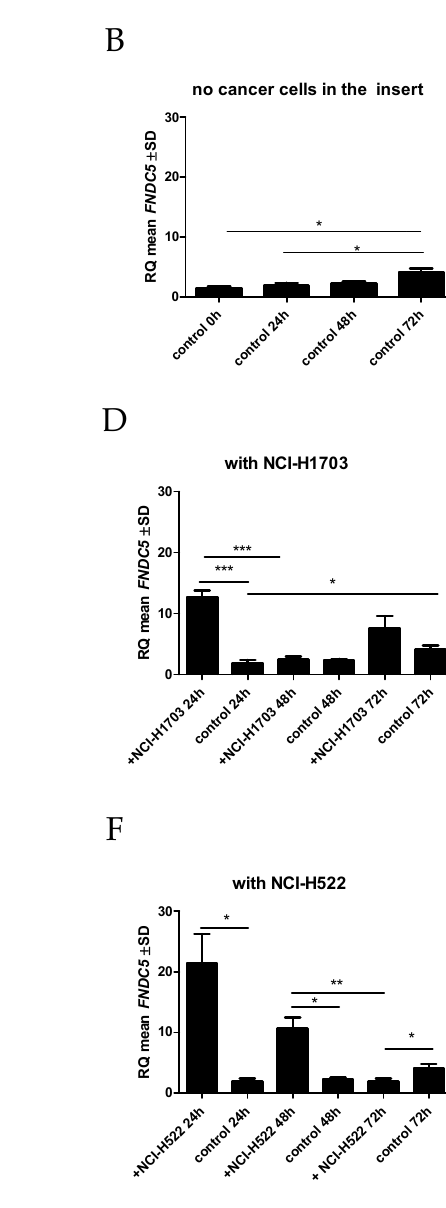
Figure 10. Comparison of the expression level of FNDC5 mRNA after co-culture in IMR-90 cells in the empty insert (control) ( A , B ) and the insert with lung cancer cells [NCI-H1703 ( C , D ) and NCI-H522 ( E , F )], * p ≤ 0.05, ** p ≤ 0.005, *** p <0.001 .